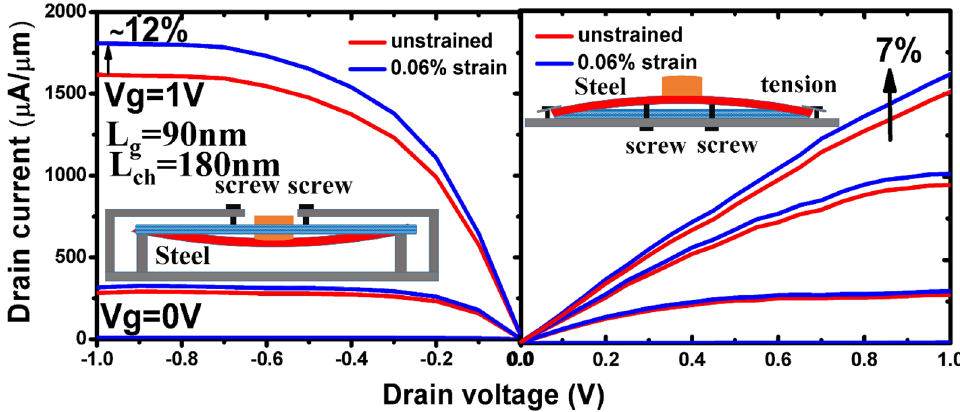
Figure 11. Enhancement of Id—Vg profiles of stacked Ge-nanosheet GAAFETs (Lch = 180 nm) by wafer bending. Current enhancement of 12% for p-FET and 7% for n-FET are obtained with compressive and tensile strains of 0.06%, respectively.